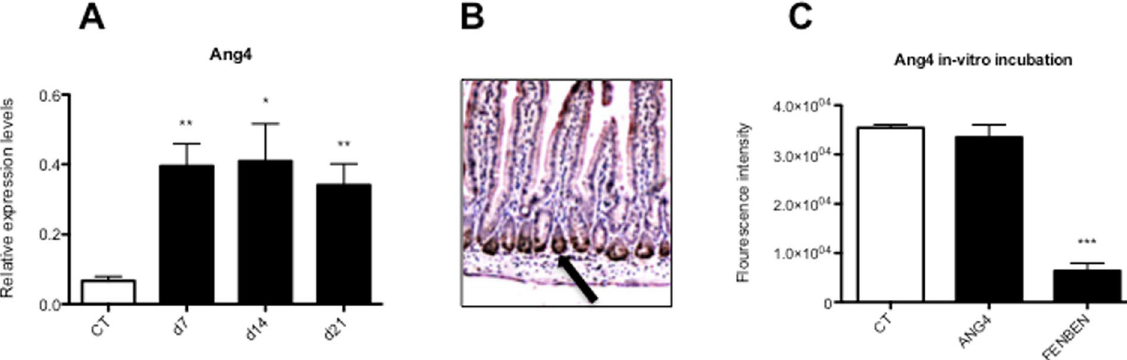
Figure 3. Ang4 is transcriptionally upregulated in paneth cells in the small intestine of mice following an infection with G . muris but has no direct effect on trophozoite viability. ( A ) Relative mRNA expression levels of Ang4 in the small intestine of C57BL/6 WT G . muris infected mice versus C57BL/6 WT uninfected controls, as measured by qRT-PCR. Expression levels were measured at day 7, day 14 and day 21 post infection ( * p < 0.05). ( B ) Histological analysis with an anti-Ang4 antibody revealed the presence of Ang4 protein in paneth cells (indicated by black arrow) in the small intestine of C57BL/6 WT infected mice. ( C ). In vitro incubation of G . muris trophozoites with angiogenin 4 recombinant protein (100 μ M) and fenbendazole (0.5 μ M) as a positive control. Metabolic activity of trophozoites was measured as fluorescence intensity of the reduced colorimetric agent resazurin ( *** p < 0.001).